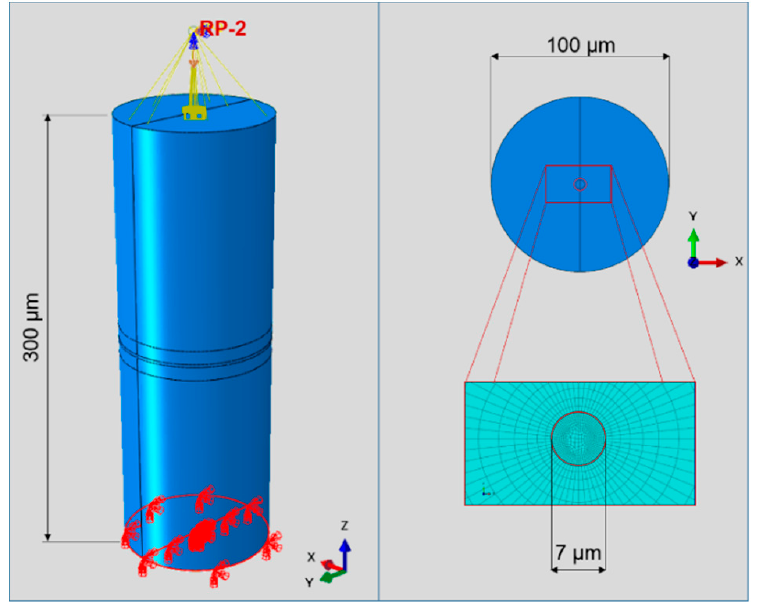
Figure 2. FE model for investigation of debonding on internal fiber stresses, setup with boundary conditions ( left ), top view with dimensions of the matrix ( top right ) and surrounded C-fiber with depicted mesh and fiber diameter ( bottom right ).